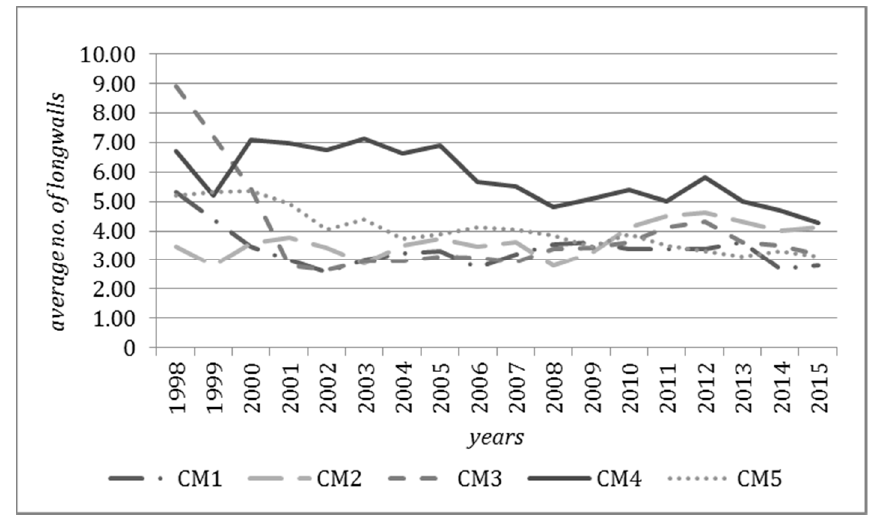
Figure 6. Average number of longwalls in the examined coalmines over the period 1998–2015. Source: own work.